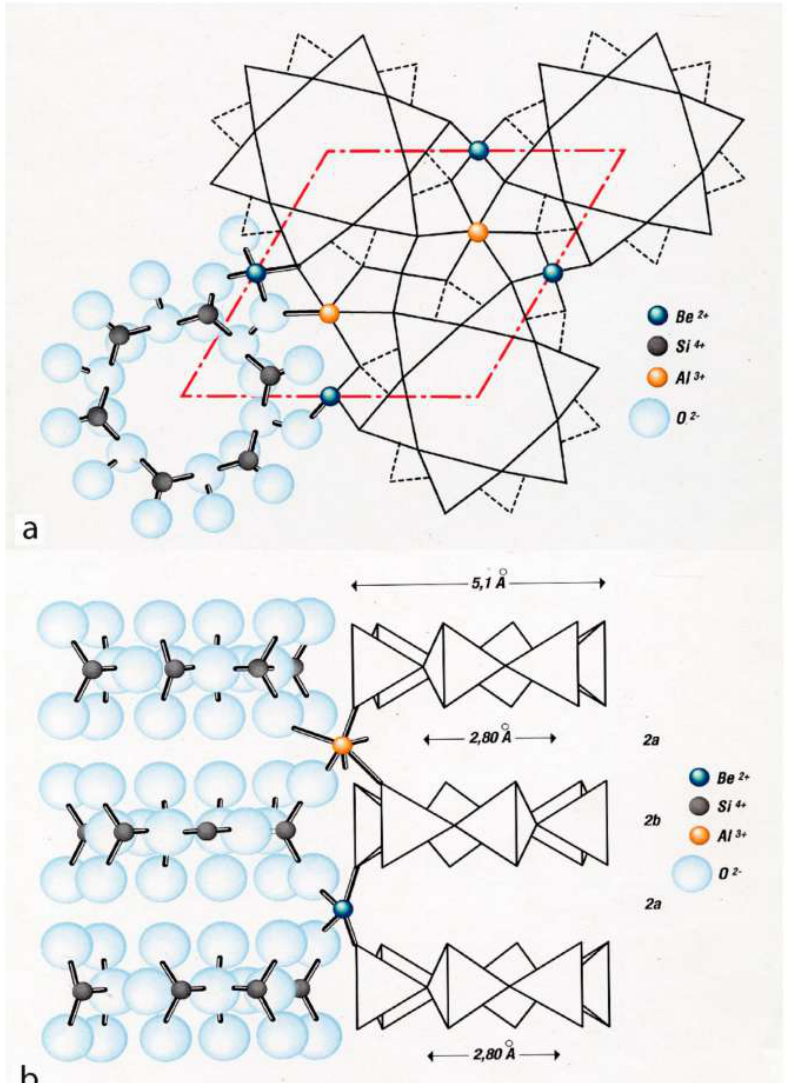
Figure 4. Structure of beryl [9] in: ( a ) Apical view: Hexagonal silicate rings stacked parallel to the c axis (normal to the drawing) are held together by Al 3+ (octahedral site) and Be 2+ (tetrahedral site). The radii of the ions are respected in the drawing; ( b ) lateral view perpendicular to the c axis showing the hexagonal silicate rings and the bottleneck (2 b site) and the open cage (2 a site)